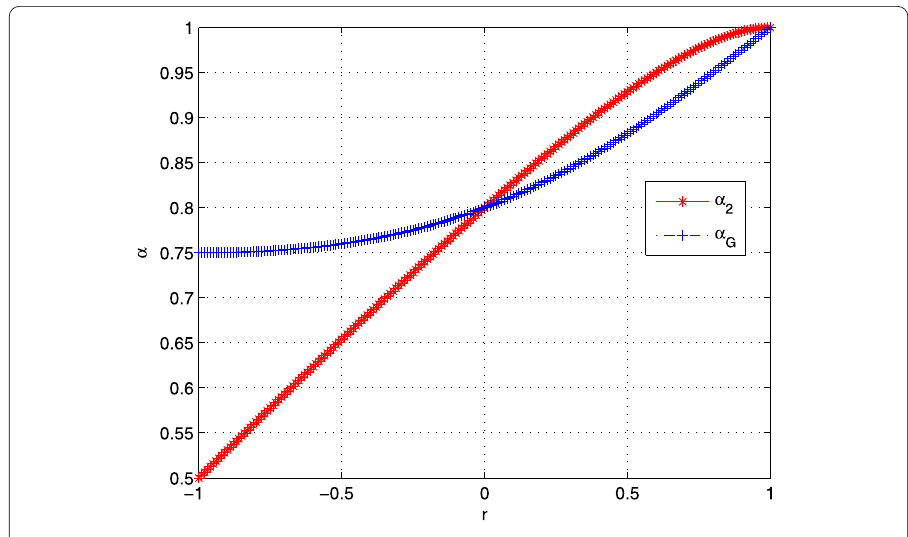
Figure 1 The curves of α 2 and α G in r ∈